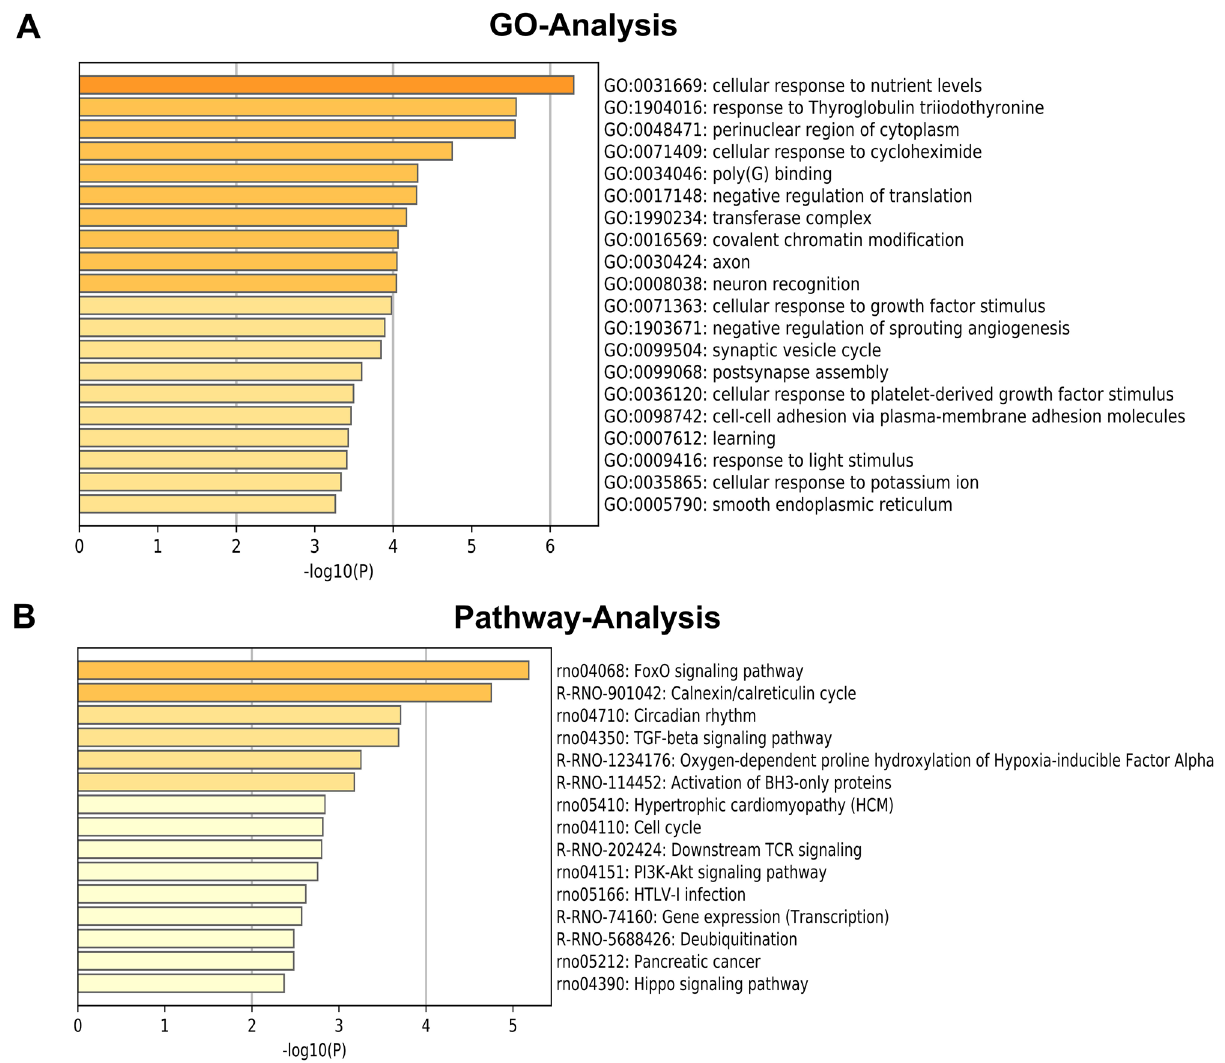
Figure 3. Gene ontology (GO) and pathway analysis for miR-148a-3p target genes. ( A ) Indicate biological process (BP), cellular component (CC) and molecular function (MF) predicted miR-148a-3p target genes. The vertical axis shows the GO terms, and the horizontal axis shows the − log10(P). ( B ) Significant pathways for predicted miR-148a-3p target genes. The vertical axis shows the pathway categories, and the horizontal axis shows the enrichment scores of pathways. P < 0.05 was used as a threshold to select significant GO categories and KEGG pathways. − Log 10p was the base 10 logarithm of the